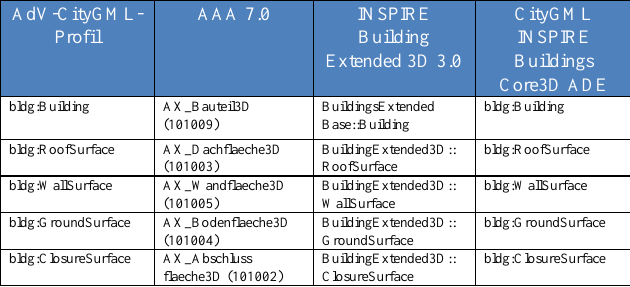
Table 1. Mapping between the schemata AdV-CityGML-Profil,